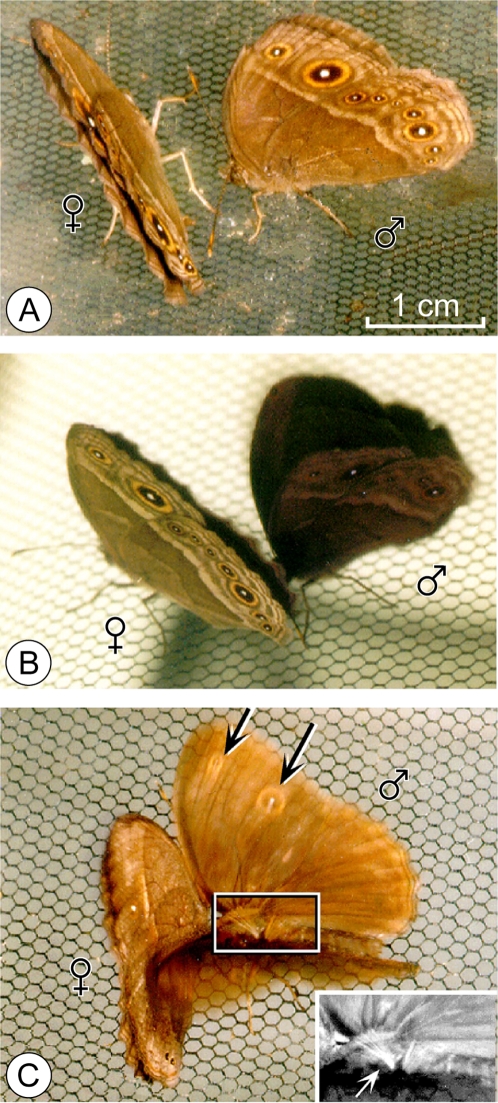
Courtship sequence of B. anynana.Steps 2 to 4 are represented here: A. Orientation: the male assumes a position at approximately 45° relative to the female body axis. B. Flickering: the male moves his wings jerkily and speedily, while the female stands. C. Thrust: the male opens his wings, revealing the fan-like hairs on the dorsal surface of the hindwing (within box with enlargement to lower right). Pictures from [52].